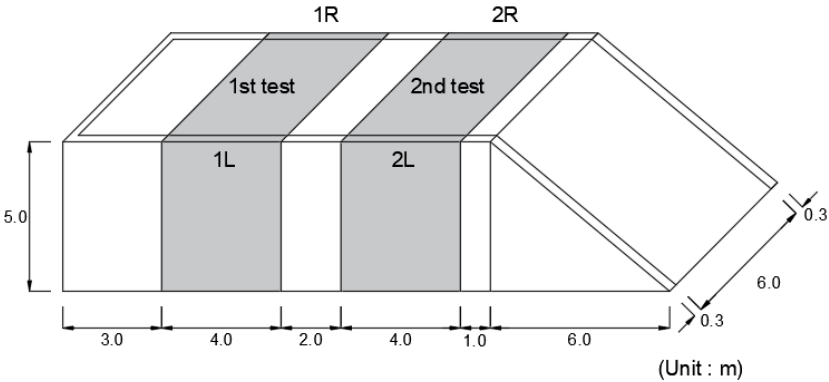
Figure 2. Schematic of the full scale RSR.